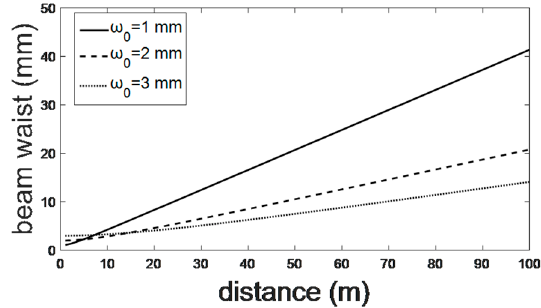
Figure 3. Beam radius as a function of distance for three initial beam waists.